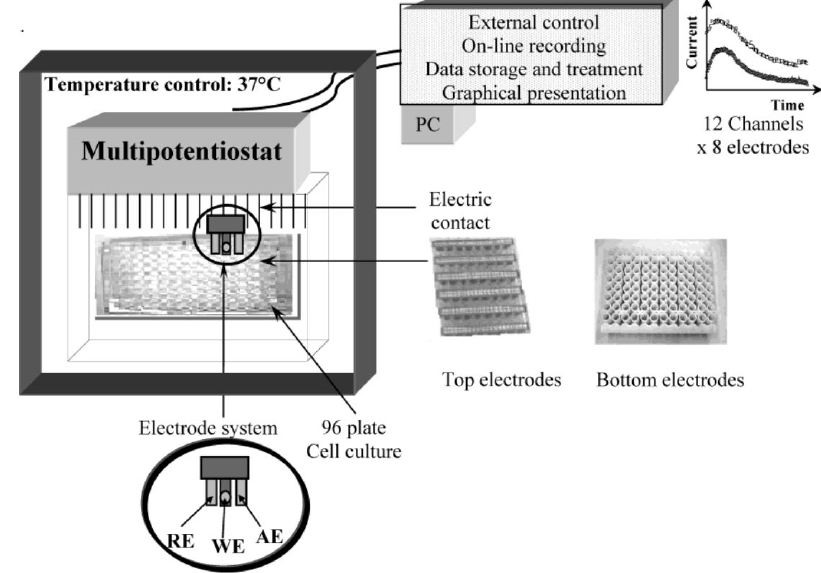
Figure 7. Schematic diagram of the multi-channel dissolve oxygen (DO x ) sensor system used for measuring cytotoxicity. Two configurations of the 96 electrodes are available with the electrodes at the top or bottom of the wells. Each sensor consists of three electrodes: reference (RE), auxiliary (CE), and working (WE) electrode. Reproduced with permission from [50], Copyright 2004, American Chemical